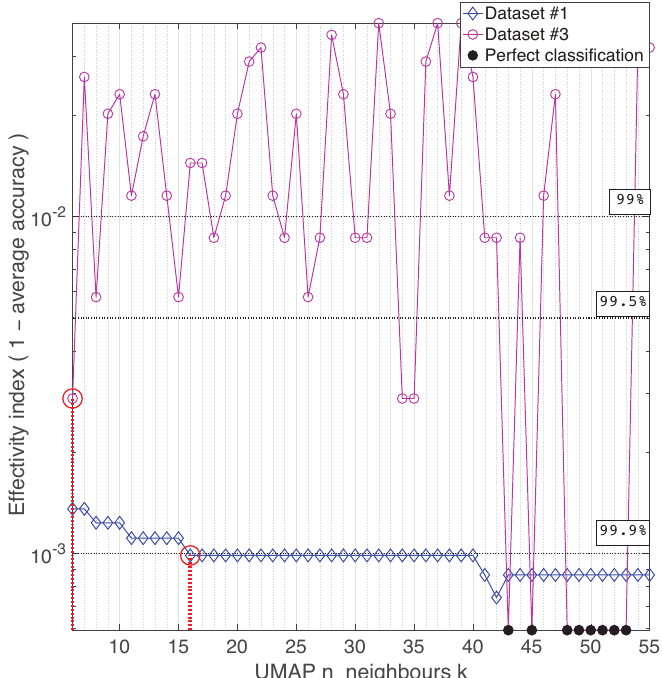
Figure 10. Average accuracy vs. the number of neighbors in the UMAP graph k for datasets #1 and #3 (semi-logarithmic plot in the vertical axis). The vertical axis represents the effectivity index, i.e., one minus the average accuracy. Perfect classifications ( ρ = 0) are marked with solid black circles. The optimal selected parameters are highlighted in red. The accuracy range for dataset #1 is from 99.864% to 99.925% and that for dataset #3 is from 96.248% to 100%.